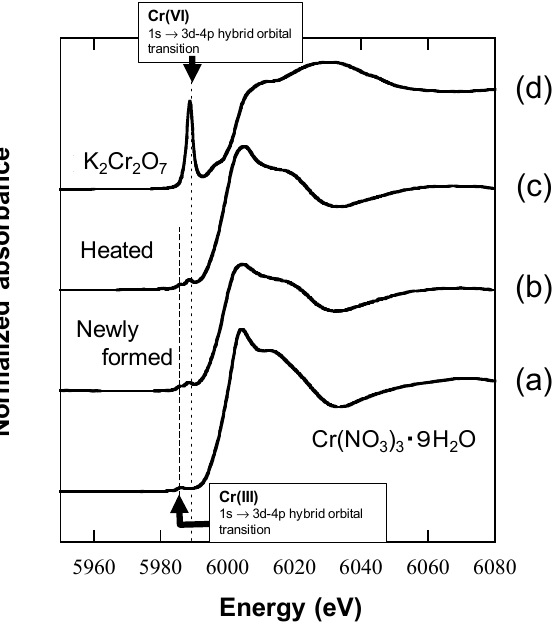
Figure 8. Cr K-edge X-ray Absorption Near-Edge Structure (XANES) of newly formed and heated BMOs treated in 0.5 mM Cr(NO 3 ) 3 solution/100 mM MES (pH 6.0) for 24 h under aerobic condition. Cr(NO 3 ) 3 · 9H 2 O and K 2 Cr 2 O 7 represent Cr(III) and Cr(VI) references, respectively. ( a ) Cr(NO 3 ) 3 · 9H 2 O, ( b ) newly formed and ( c ) heated BMOs treated in Cr(NO 3 ) 3 , and ( d ) K 2 Cr 2 O 7